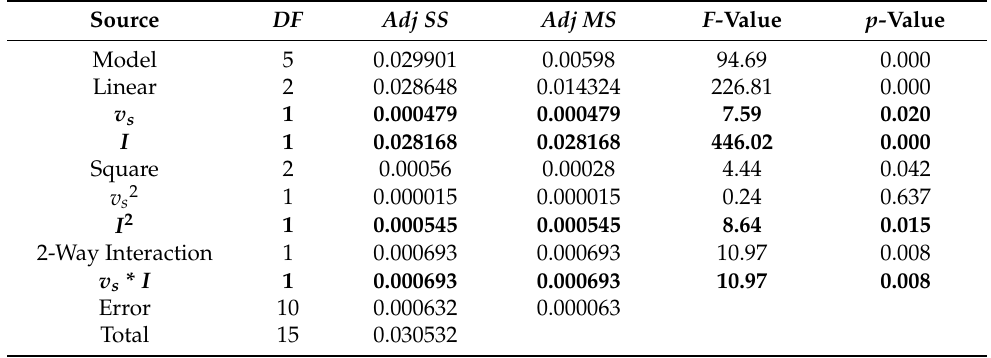
Table 4. ANOVA for the cutting speed ( v ). Significant regression coefficients are listed in bold typeface. Source DF Adj SS Adj MS F-